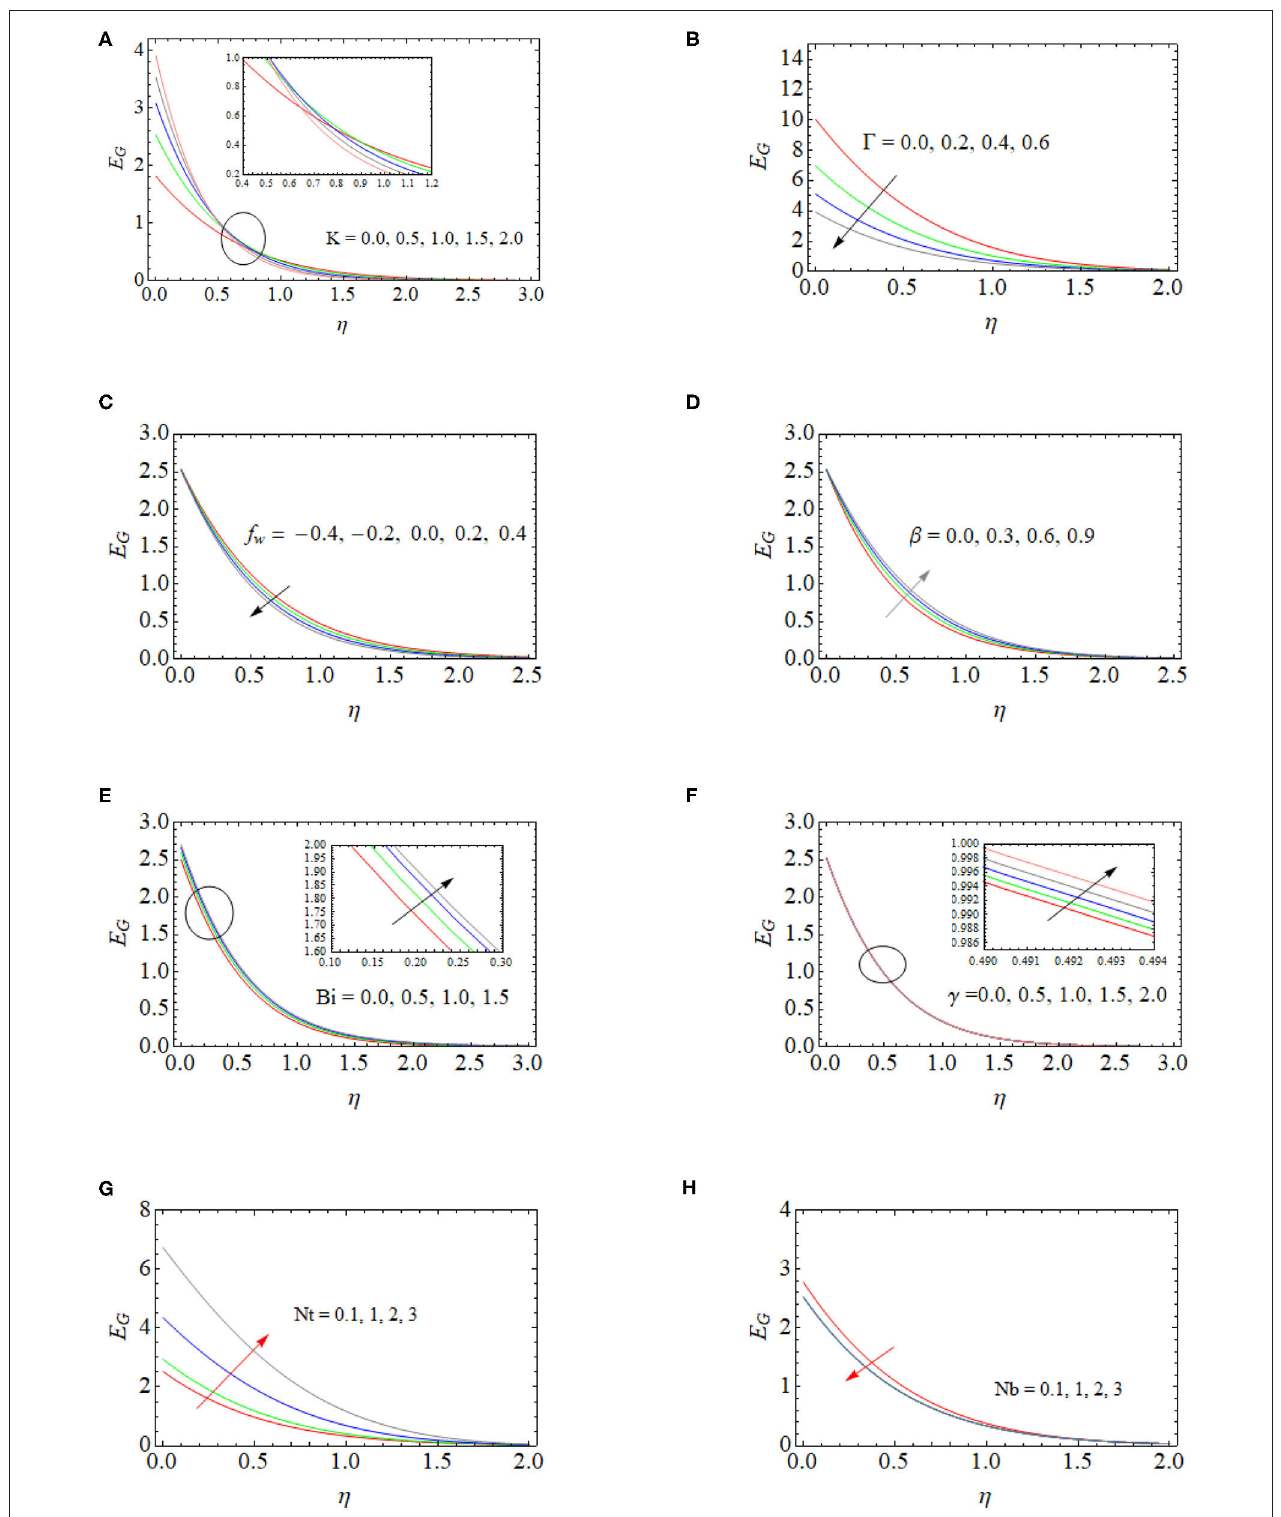
FIGURE 6 | (A–H) Impacts of K , Ŵ , f w , β , Bi , γ , Nt , and Nb on entropy generation E G .